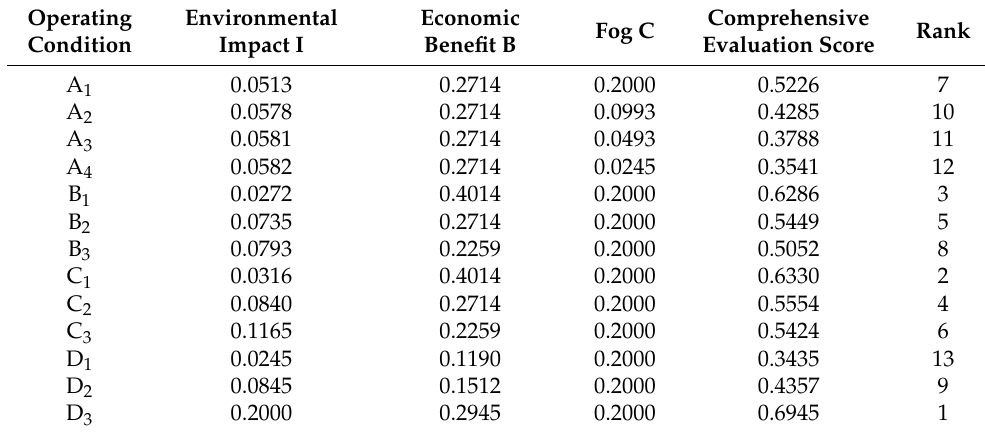
Table 4. Comprehensive evaluation score and ranking of each operating condition.